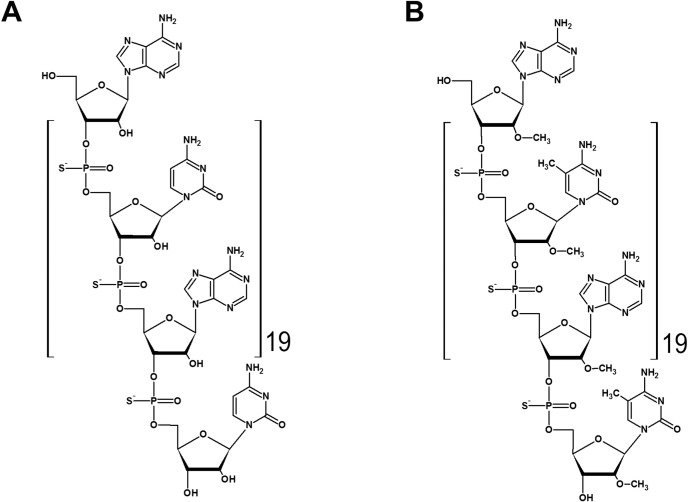
Chemical structures of REP 2055 (A) and REP 2139 (B).